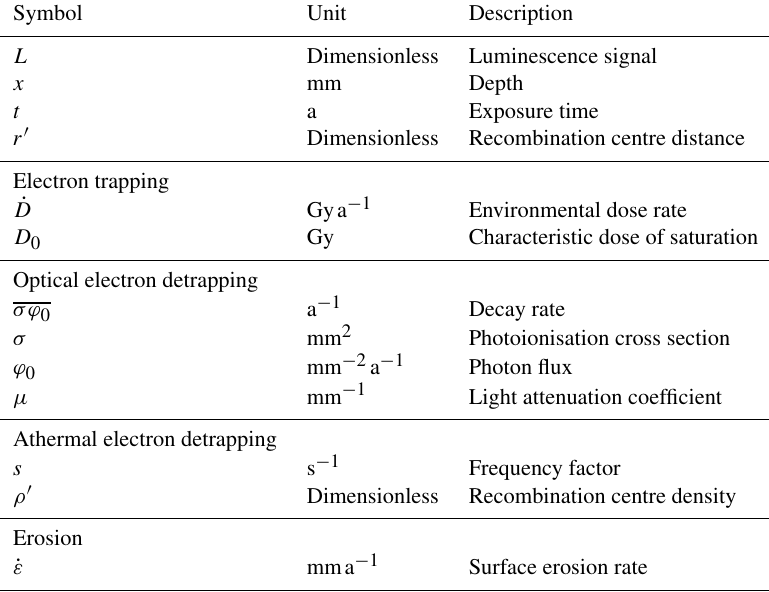
Table 3. Symbols used in the luminescence surface exposure dating model. Symbol Unit Description L Dimensionless